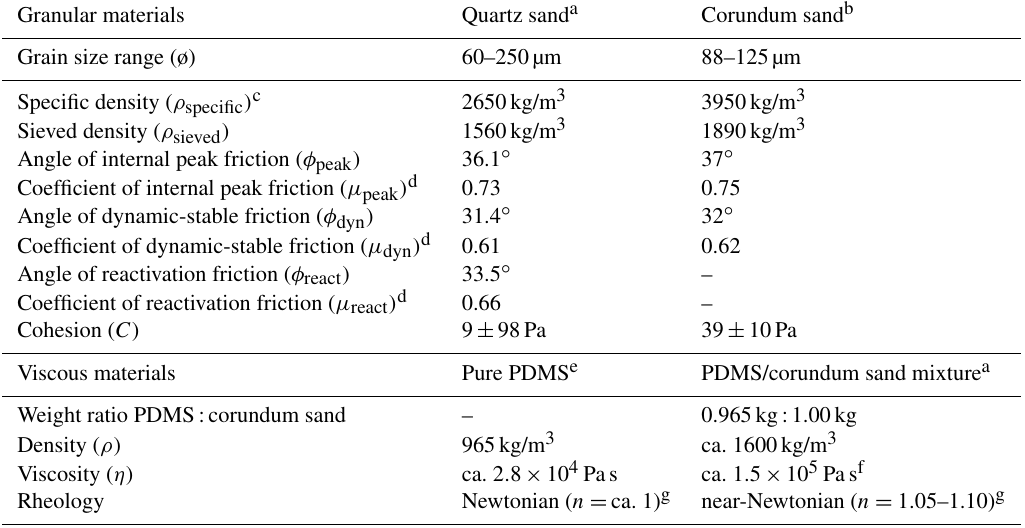
Table 1. Model materials.